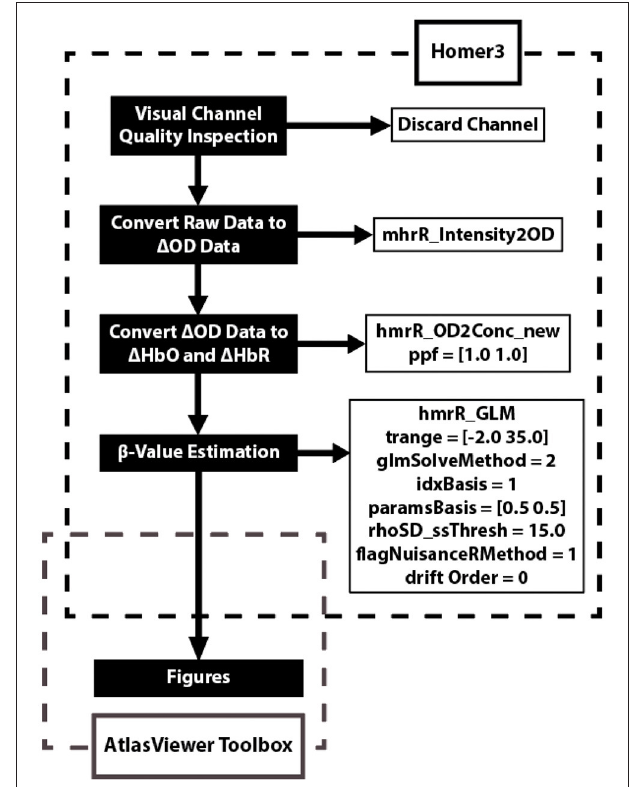
FIGURE 2 | Data analysis flow chart applied to each fNIRS channel. The data analysis utilizes two open source toolboxes: Homer3 (v1.26) and AtlasViewer (v2.12.4) Toolboxes. The Homer3 toolbox provides a user-friendly graphic user interface (GUI) that allows for the creation of easy-to-use data analysis pipelines and figures. The functions and parameters used in Homer3 are provided in the dashed black box. First, raw fNIRS signals were converted into changes in optical density data by taking the logarithm of the signal. Second, the changes in oxygenated-hemoglobin ( 1 HbO) concentrations were then obtained using the modified Beer-Lambert law with a partial pathlength factor of 1. Third, the hemodynamic response function (HRF) was then estimated by a general linear model (GLM) approach that uses iterative weighted least squares ( Barker et al., 2013). Finally, figures were created using